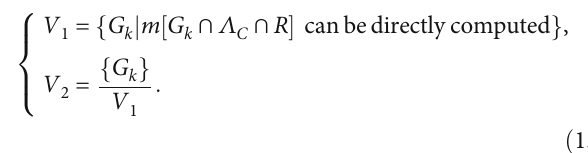
, Λ Π ð G , R Þ k C Þ and k